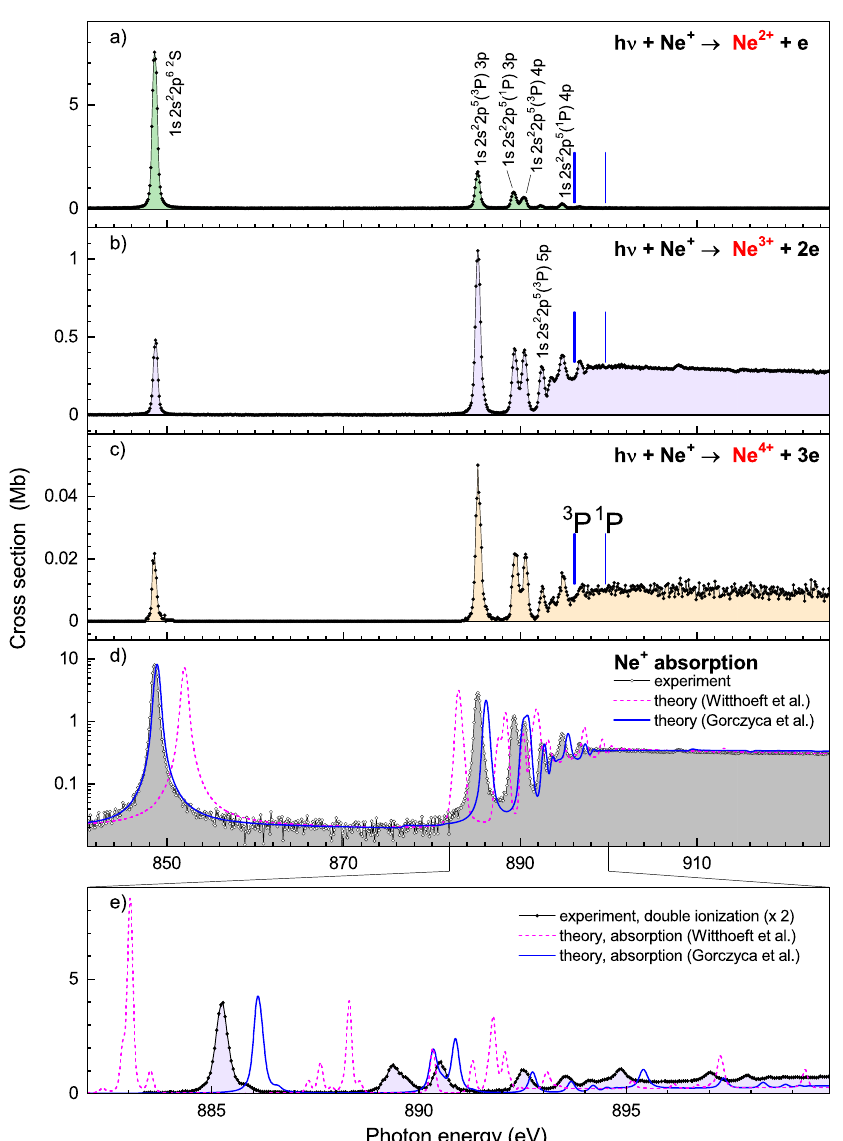
Figure 5. Cross sections for ( a ) single ionization, ( b ) double ionization, and ( c ) triple ionization of Ne + ions [33] measured with a photon energy bandwidth of 500 meV. The experimental cross section in panel ( d ) is the sum of the cross sections displayed in panels ( a – c ). It represents the Ne + absorption cross section, which is compared with the theoretical cross sections of Gorczyca et al. [42,88,89] and Witthoeft et al. [90]. Panel ( e ) presents a comparison between the theoretical results with a high-resolution measurement (113 meV photon-energy bandwidth) of the cross section for double ionization (multiplied by a factor of 2) over a narrower energy range. For the comparisons, the theoretical cross sections were convolved with gaussians with full-widths-at-half-maximum of 500 meV in panel ( d ) and 113 meV in panel ( e